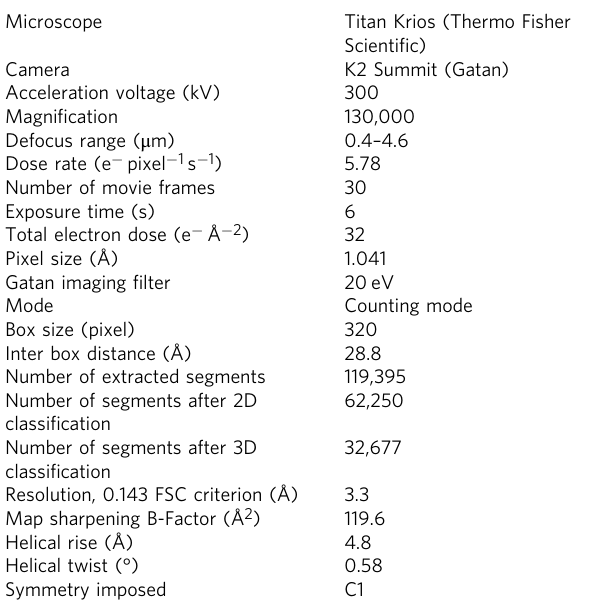
Table 1 Cryo-EM data collection and image processing